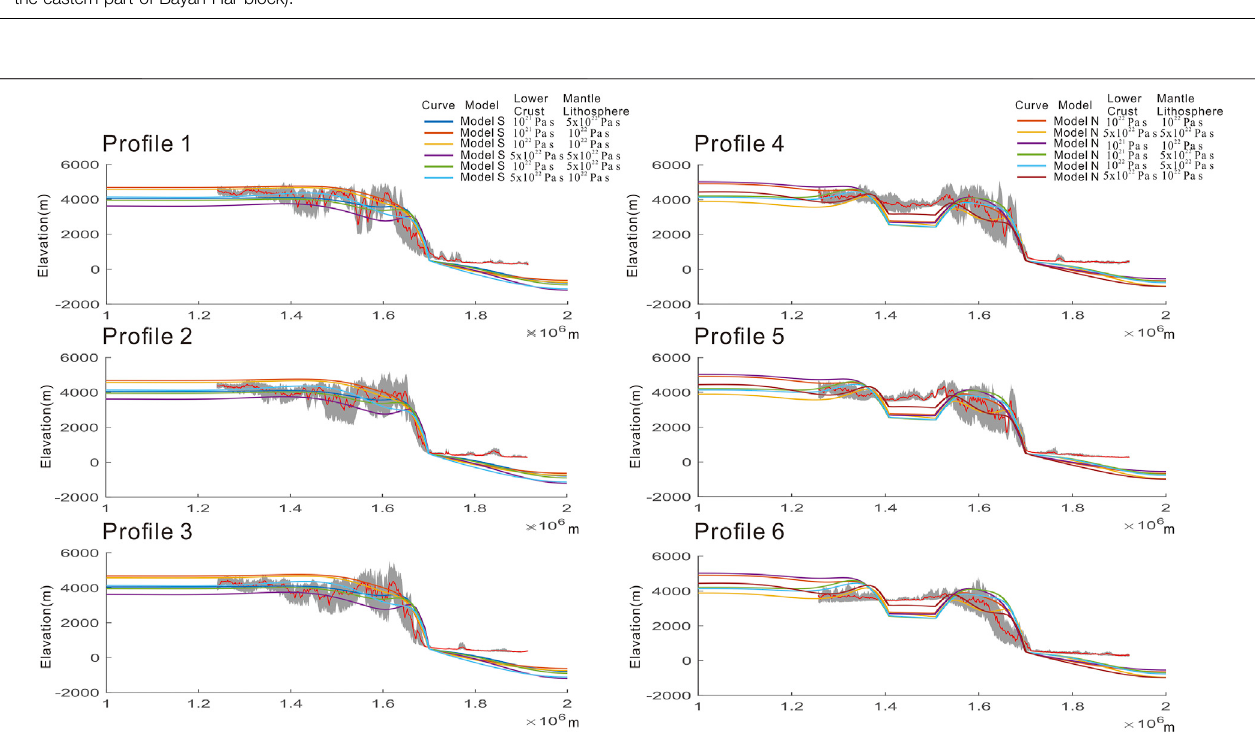
FIGURE 4 | Combination of the average altitude curves along the 6 pro fi les. The light blue area is the block area, and the pink area indicates the fault zone. LRB- Longriba fault; LMS-Longmen Shan fault; LMS block-Longmen Shan block (the Longmen Shan block is the area between the Longriba fault and Longmen Shan fault in the eastern part of Bayan Har block).